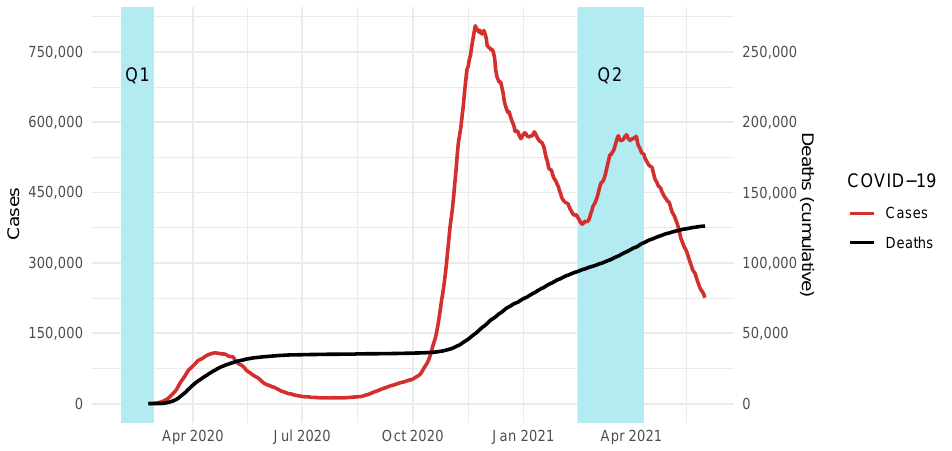
Figure 1. COVID-19 cases and death in Italy compared to questionnaires’ administration timing (Q1 and